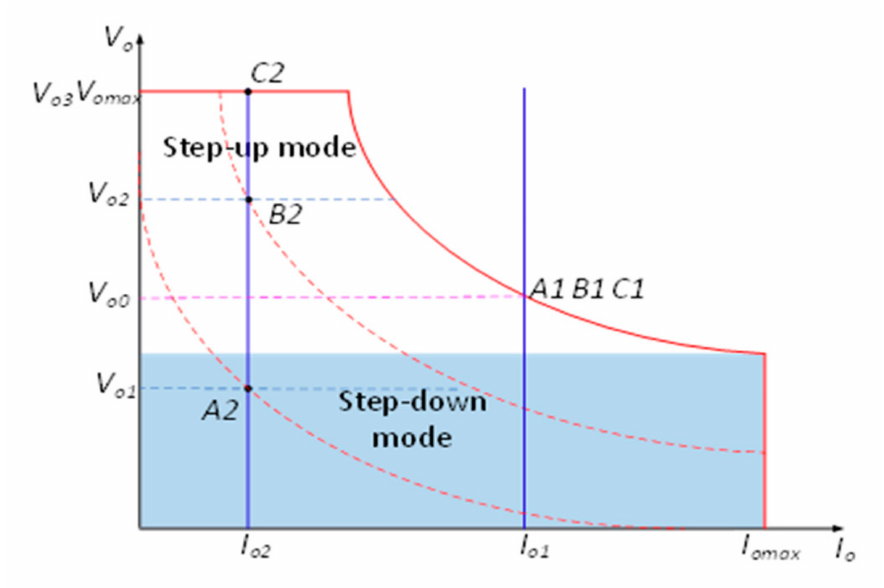
Figure 12. The output characteristic of series-connected PV MVDC